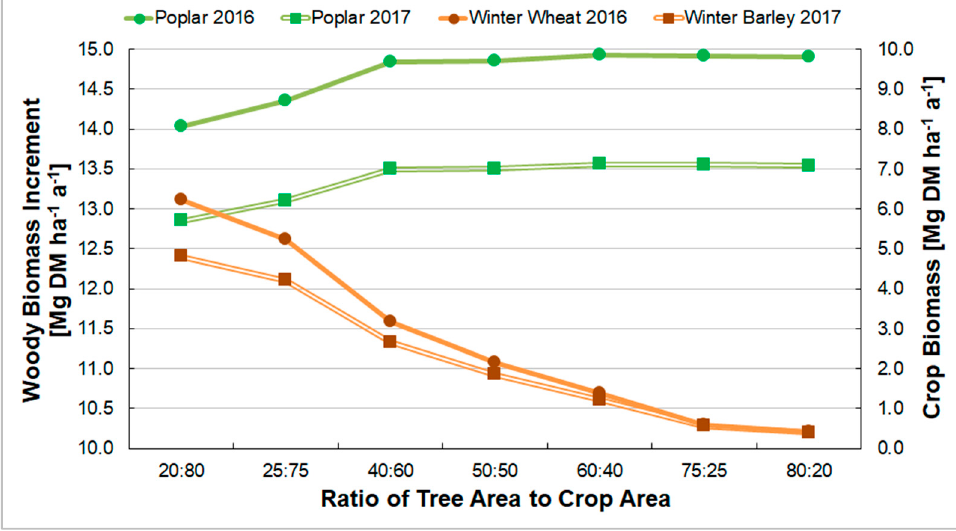
Figure 6. Above-ground tree woody biomass and crop yields, as simulated by the Yield-SAFE model at Neu Sacro, under different ratios of tree area to crop area.